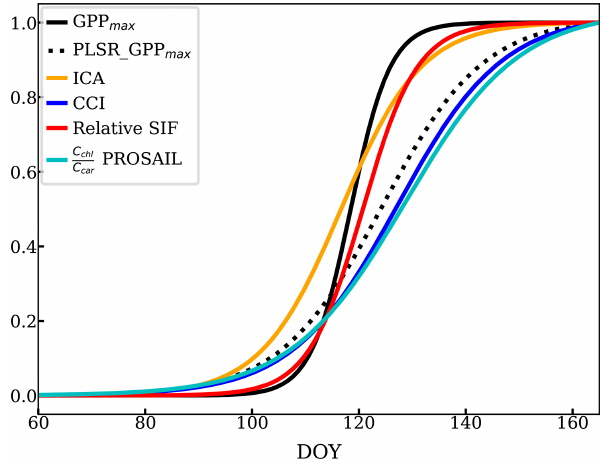
Figure 9. Temporal evolution of the growing season onset using sigmoid fits (scaled) of PLSR, ICA, CCI, chlorophyll-to-carotenoid ratio, and relative